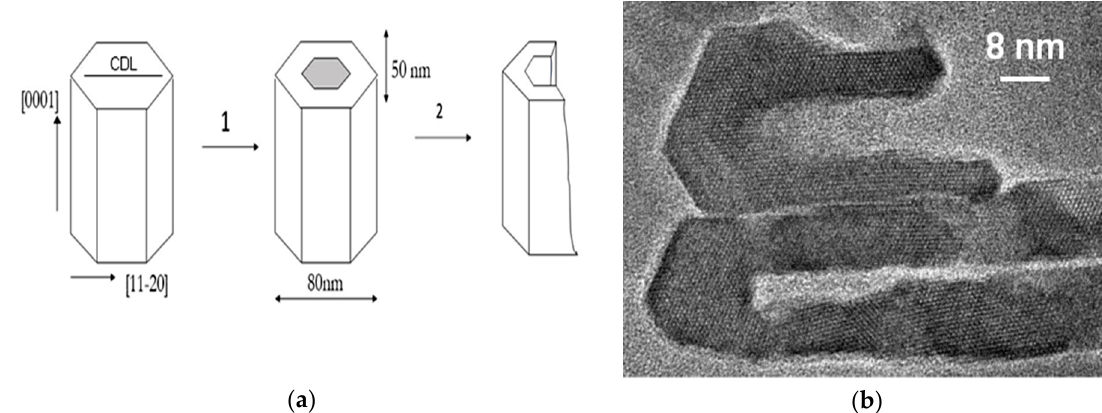
Figure 2. ( a ) Graphic representation of the dissolution of the enamel crystals of human teeth by acid attack. This starts from the center of the crystal. ( b ) HRTEM image of enamel crystals in step 2 of an enamel sample after treated with orthophosphoric acid for simulating acid attacks.